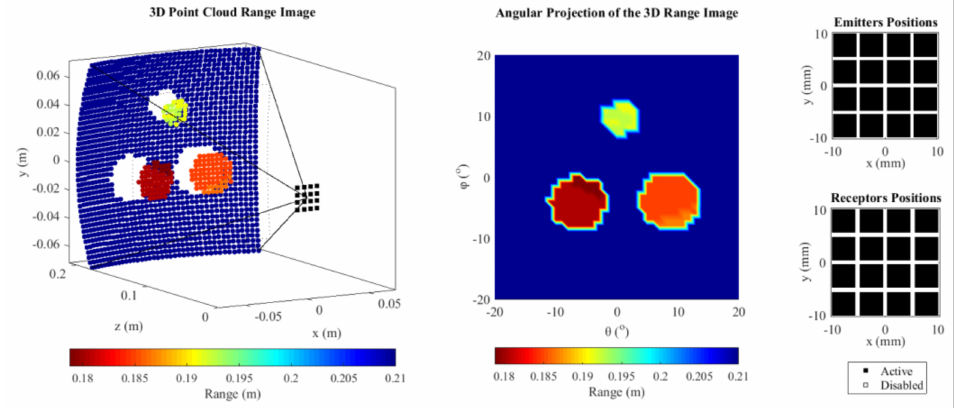
Figure 20. The images formed from all FMC data sets improved the geometric definition of the targets. The greater amount of signals decreased the threshold from − 20 dB to − 30